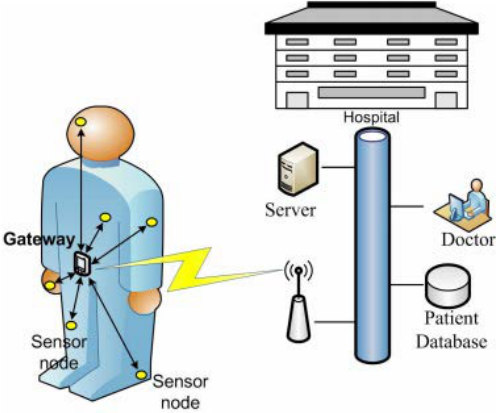
Figure 1. Network illustration of an on-body IoT network. The on-body sensor communicates to a gateway, which then forwards the data to a central database with the